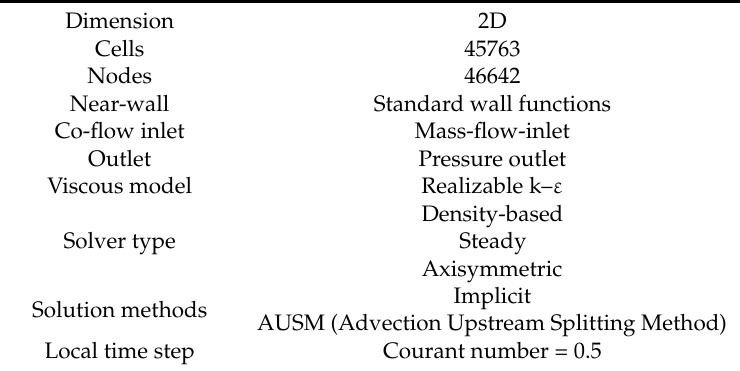
Table 3. Parameters and settings of the computational fluid dynamics (CFD) model.